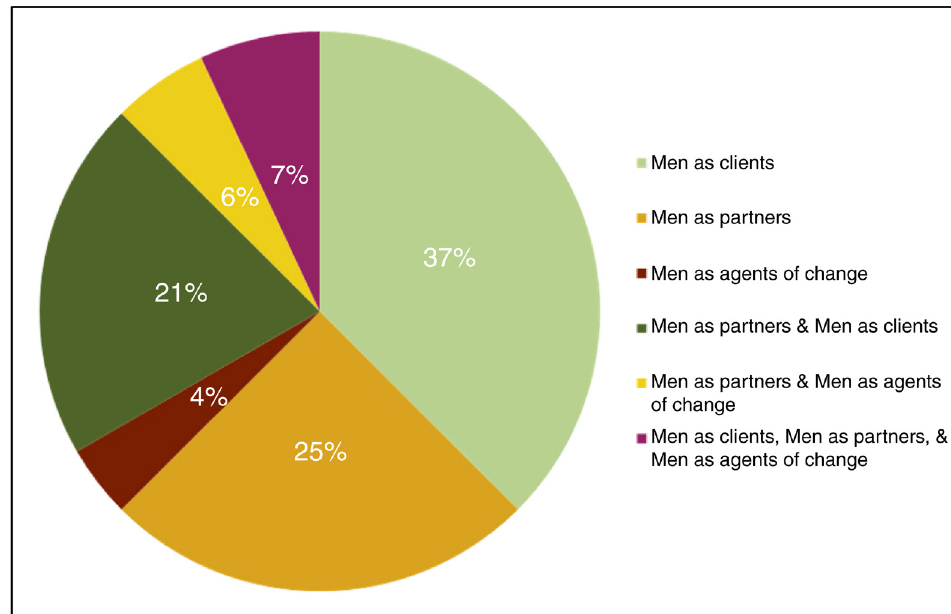
Figure 1. Approaches to engaging men in family planning